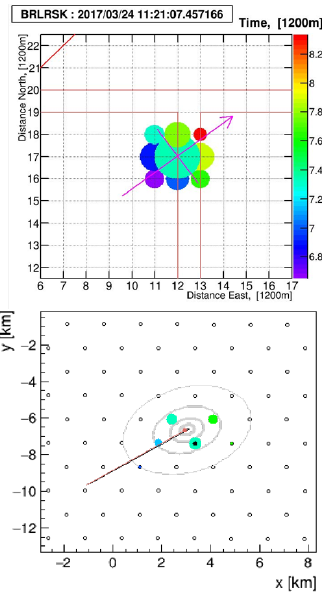
Figure 5. (Top) One of the events reconstructed by TA that landed near the TA CLF. The distances are expressed in unit of separation between TA stations (1200 m). (Bottom) Simulated Auger shower using the TA reconstruction parameters with the energy scaled down by 10.4% to account for the di ff erence in en- ergy scale between Auger and TA. The detectors shown on the grid are arranged in the regular Auger triangular pattern (1500 m